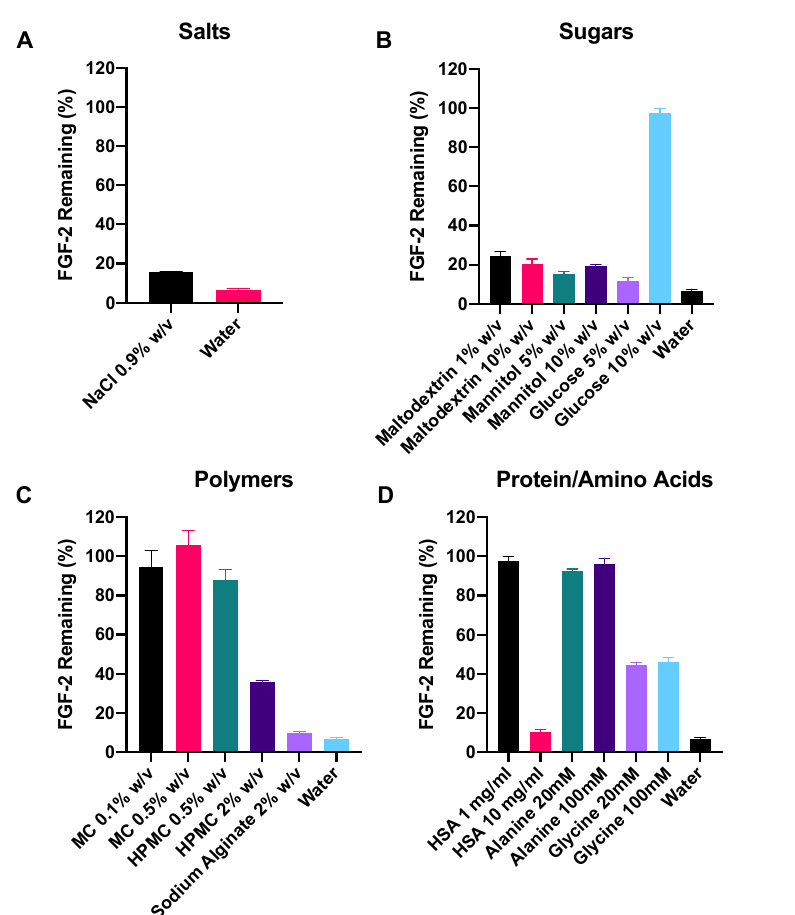
Figure 3. Effect of excipients on the stability of FGF-2 aqueous solution (770 ng/mL) incubated at 25 °C for 2 h. Excipients were selected from the four classes of protein stabilisers, ( A ) salts ( B ) sugars, ( C ) polymers and ( D ) protein/amino acids. FGF-2 content as analysed by ELISA following the incu- bation period is expressed as a percentage of the baseline FGF-2 content (mean ± SD, n = 3). Excipient abbreviations: sodium chloride, NaCl; methylcellulose, MC; hydroxypropyl methylcellulose, HPMC; and human serum albumin, HSA.